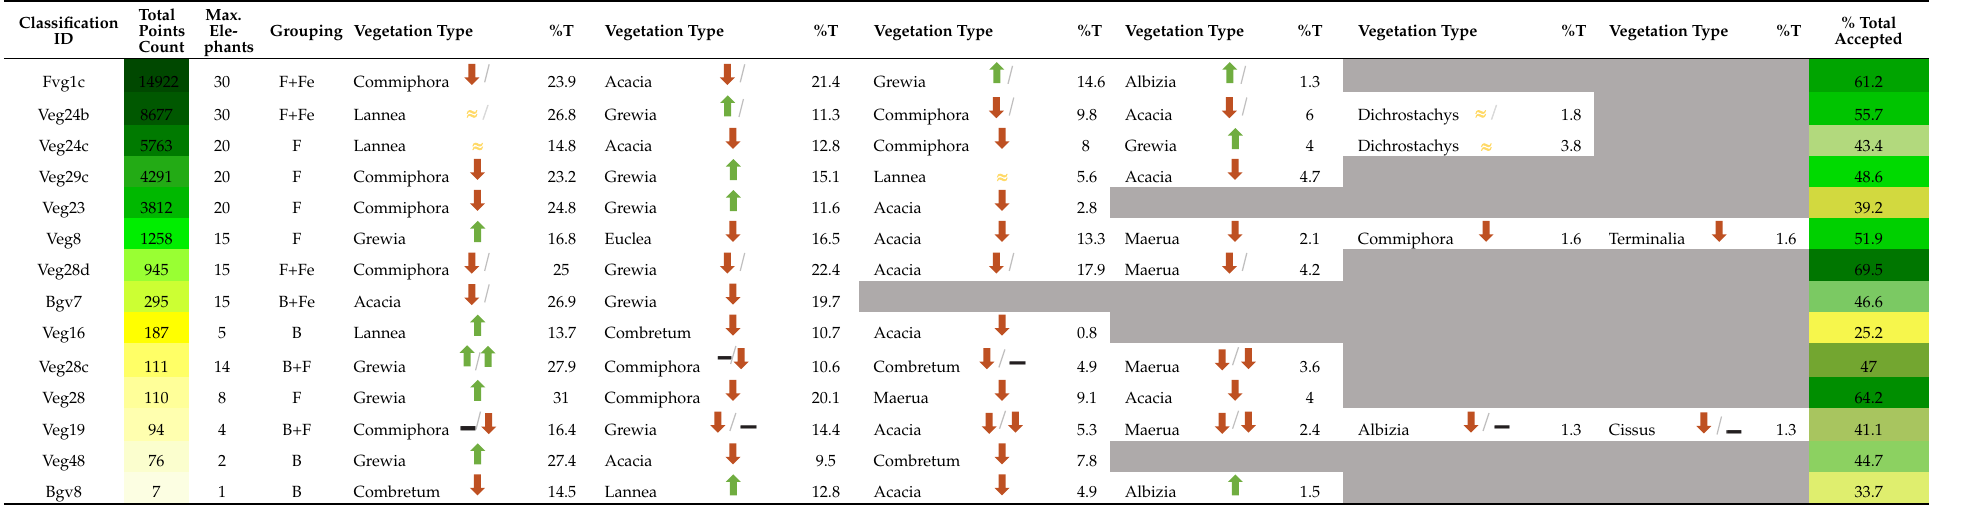
acceptance = No acceptance. = No